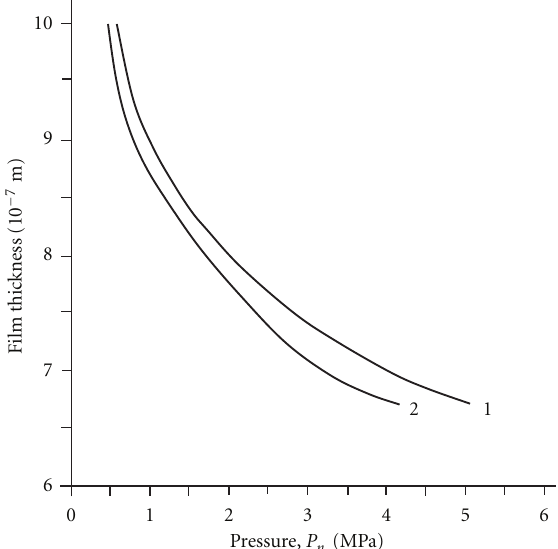
Figure 10: Dependence of the thickness h of the oil film on the pressure: 1 − P = 2%, 2 − P =